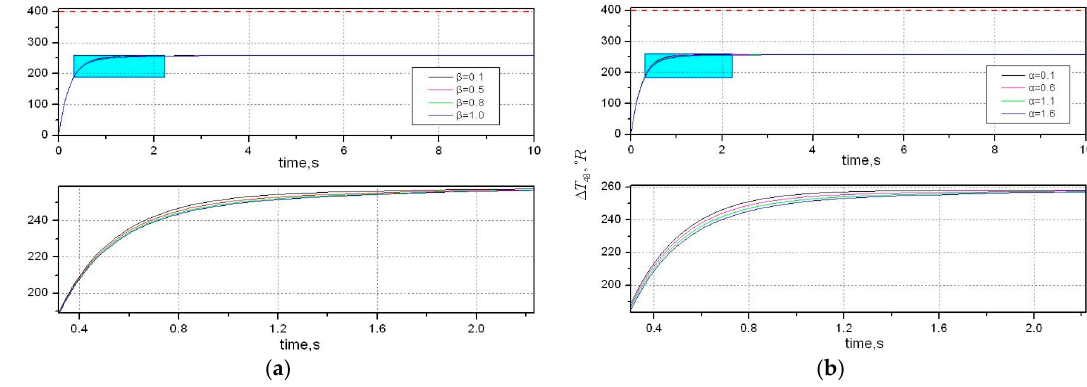
Figure 6. Fan speed response with uncertainty in system parameters. ( a ) Case 1 by taking β = 0.1,0.5,0.8,1.0; and ( b ) case 2 by taking ∂ = 0.1,0.6,1.1,1.6.